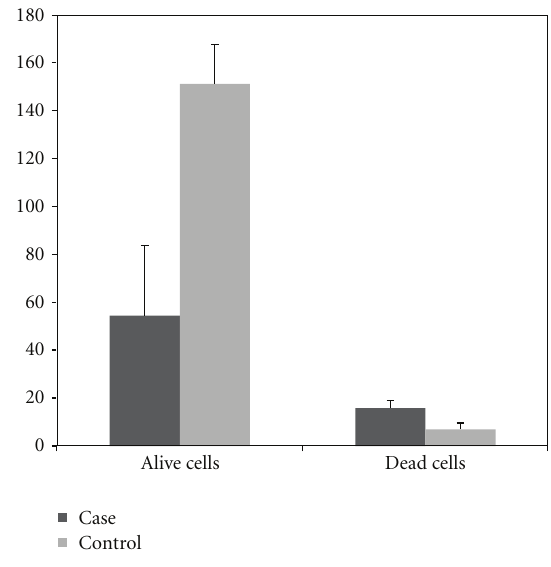
Figure 1: The the number of viable or dead cells ( × 10 5 ) in flasks of WEHI-164 fibrosarcoma cells 48 h after treatment with 100 hydatid cyst protoscolices compared to control cells (mean of triplicate performance).